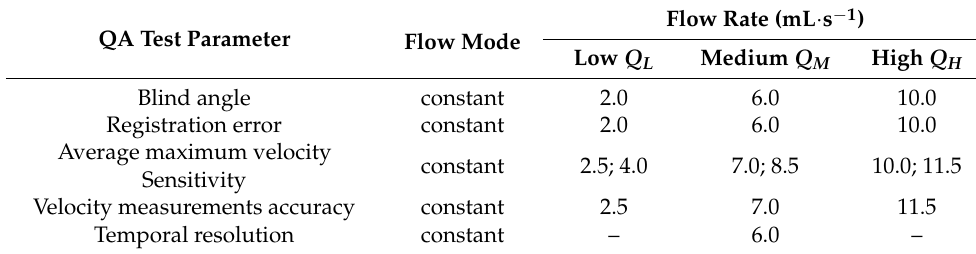
Table 3. Flow rate regimes settings according to the test